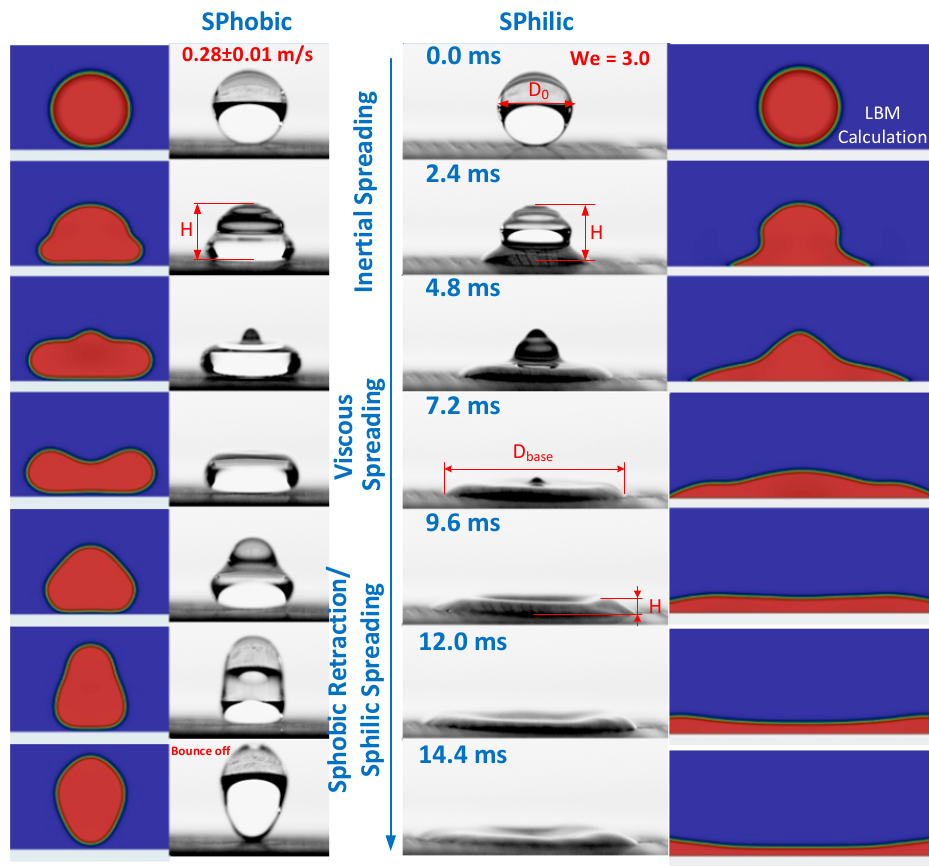
Figure 6. Comparison of the calculated and experimental dynamics of the water droplet interaction ( D 0 = 2.9 mm) with superhydrophobic and superhydrophilic surfaces. The colors shows qualitatively different densities to recognize the interface.